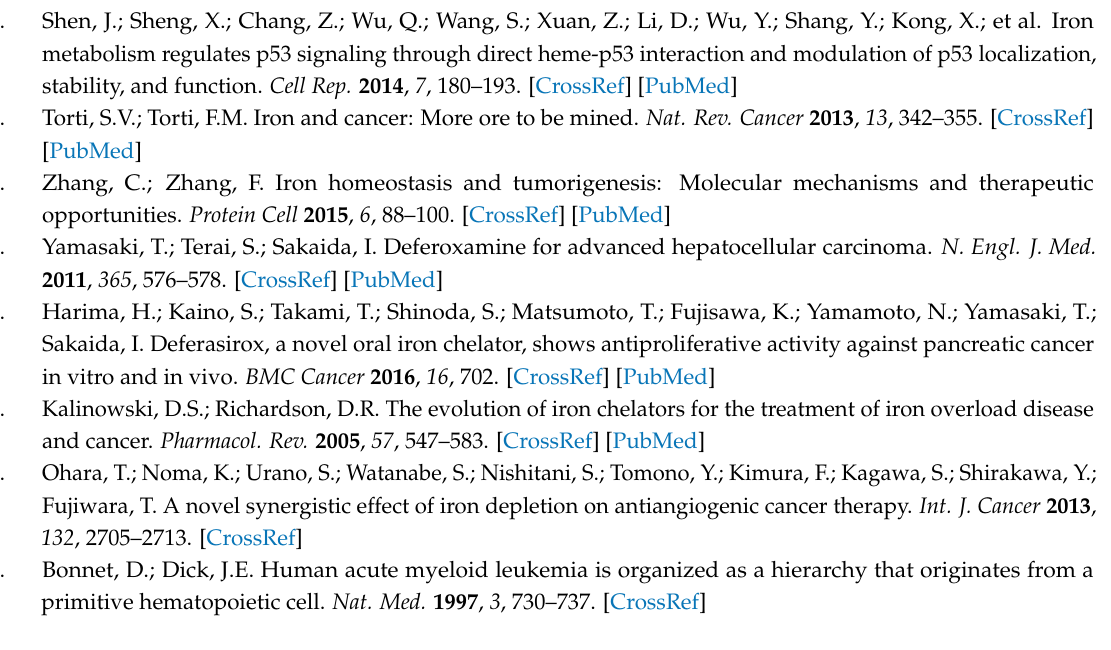
Figure S1: miPS cells (5 × 105 per mouse) treated with 0.2% DMSO or 50 µ M DFX were implanted subcutaneously into the right flank, and tumorigenicity was evaluated. There were no significant differences between groups. Data are represented as average ± S.E.M. ( n = 5), Figure S2: HSC-2 cells (3 × 106 per mouse) were injected subcutaneously into the right flank of 24 mice. On day 2 when the tumors reached 150~200 mm 3 , mice were randomly assigned to one of four groups ( n = 6 per group), and the treatments were initiated as indicated. The mean body weight of each group ± S.E.M. for comparison between groups are shown. There were no significant differences between groups, Figure S3: Cultured WI38 cells and FEF3 cells were treated with different concentrations of DFX for 48 h, and cell viability was evaluated with the XTT assay. The cytotoxity of DFX against WI38 cells and FEF3 was very low. Cell viability in the absence of treatment was set at 100%, Figure S4: Experiment of Nanog, Stat3 and phosho-Stat3 was evaluated with western blot analysis. β -actin was used as a loading control. DFX and combination treatment suppressed the expression of Nanog, Stat3 and phosho-Stat3 in HSC-2 cells, Figure S5: (A) Experiment of iron-related markers (FPN, FtH, TfR, DMT-1) was evaluated with western blot analysis. β -actin was used as a loading control. DFX suppressed the expression of iron-related markers except TfR in HSC-2 and OE33 cells. (B) Densitometric analysis of western blot also showed that DFX suppressed the expression of iron-related markers except TfR in HSC-2 and OE33 cells. Statistical significance was determined as * p ≤ 0.05, Figure S6: (A) HSC-2 and OE33 cells treated with different concentrations of DFX for 48 h were analyzed by flow cytometry. CD44 antibody was used as a stemness marker. Living CD44 positive cells ratio was decreased by DFX. (B) Total RNA of HSC-2 and OE33 cells treated with DFX with indicated concentrations were used in the PCR analysis. The mRNA of Nanog was suppressed by DFX in a dose-dependent manner. Relative expression level in the absence of treatment was set at 1. Statistical significance was determined as * p ≤ 0.05, Figure S7: (A) Experiment of migration ability was performed with scratch assay. HSC-2 and OE33 cells were seeded in 6well plates and treated with different concentrations of DFX. Migration ability was evaluated with indicated time. DFX suppressed the migration ability in HSC-2 and OE33 cells. (B) Scratch assay was quantitively analyzed as area of gap with Image J software. * p < 0.05. Scratched area was remained by DFX in a dose-dependent manner, Figure S8: Experiment of vascular endothelial growth factor secretion was performed with ELISA assay. The supernatant was collected with indicated concentration of DFX. DFX induced vascular endothelial growth factor secretion in HSC-2 and OE33